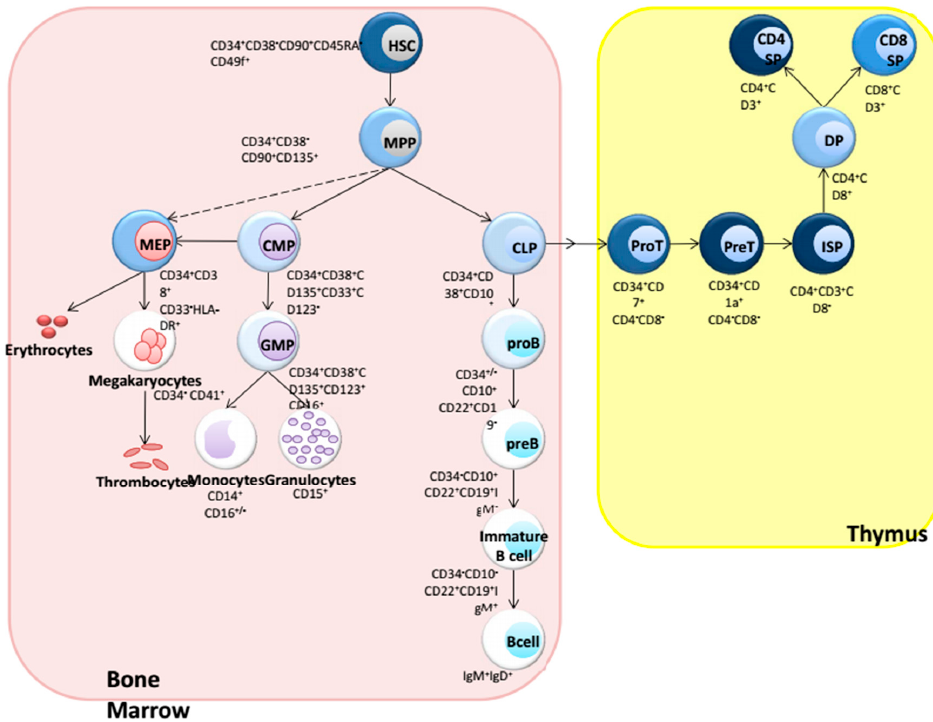
Figure 1. Normal human hematopoiesis. All blood cells are derived from a rare population of stem cells, which give rise to more lineage restricted progenitor cells that largely lack self ‐ renewal. T ‐ lymphocytes develop in the specialized microenvironment of the thymus. Wnt signaling is highest in the thymus, but also present in HSCs, CMP, CLP, and at low levels in pro B cells. The intensity of the blue color indicates the levels of Wnt signaling in the subpopulations depicted. All mature blood cells lack Wnt signaling, except a significant fraction of peripheral T cells. Data from Wnt signaling levels are derived from